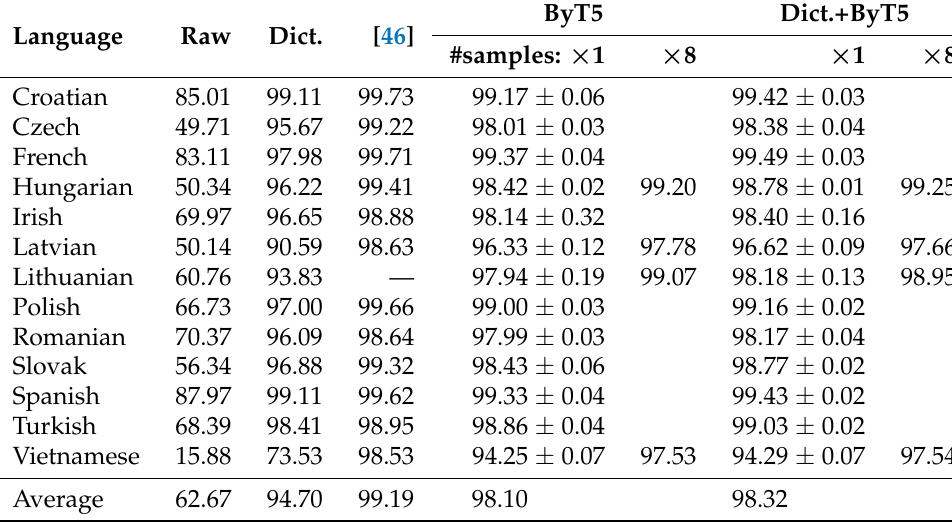
Table 3. Alpha-word accuracy results (%) for the diacritics restoration task. We report means and standard deviations for three separate training runs with different initial model weights and dataset samplings trained for 524288 sentences (#samples: × 1) and a single run for eight times more( × 8), cycling through the available training data (Table 1) as